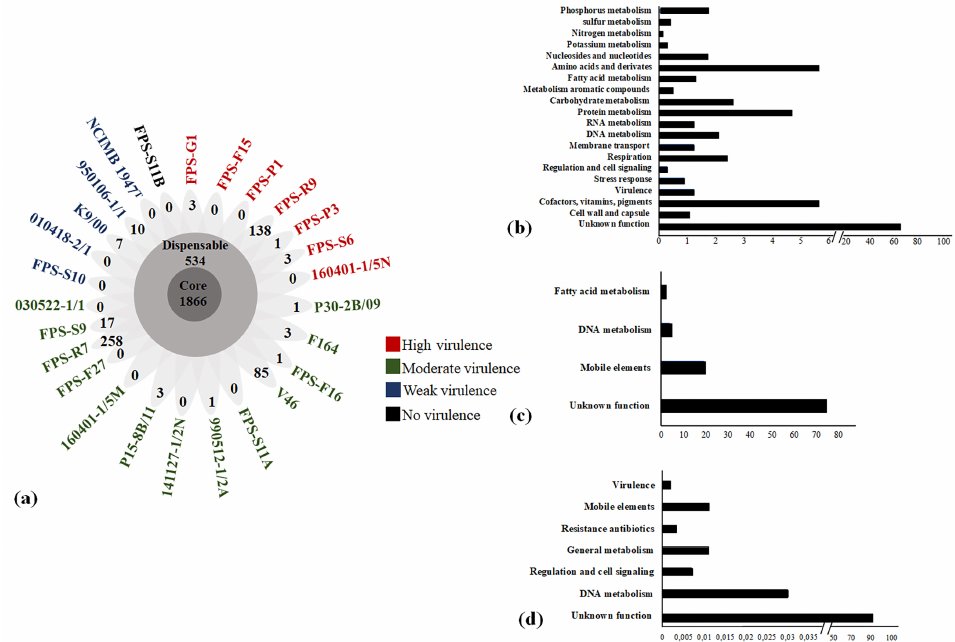
Figure 1. Pan-genome of F. psychrophilum isolates. ( a ) The flower plot represents the number of shared (core), dispensable, and accessory genes based on cluster orthologs for each DNA sequence. Petals display numbers of strain-specific genes (accessory genome) found in each genome of F. psychrophilum . The array of colors indicates the virulence category as found in the juvenile rainbow trout model [4]. ( b ) COG subcategories of predicted genes within the core genomes of F. psychrophilum isolates. Each category is graphed as a percentage of the total number of genes in the core pool of genes. ( c ) COG subcategories of predicted genes within the dispensable genome of F. psychrophilum isolates. Each category is graphed as a percentage of the total number of genes in the dispensable pool of genes. ( d ) COG subcategories of predicted genes within the accessory genome of F. psychrophilum isolates. Each category is graphed as a percentage of the total number of genes in the accessory pool of genes.